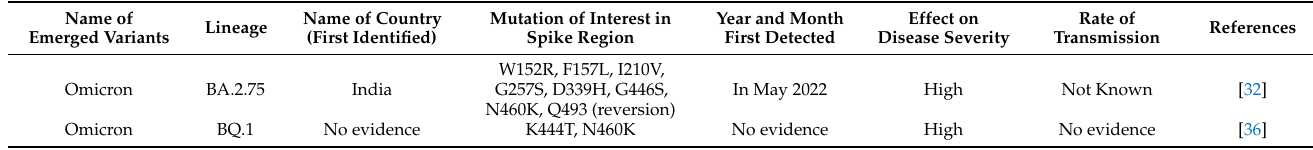
Table 4. Variants of Interest.